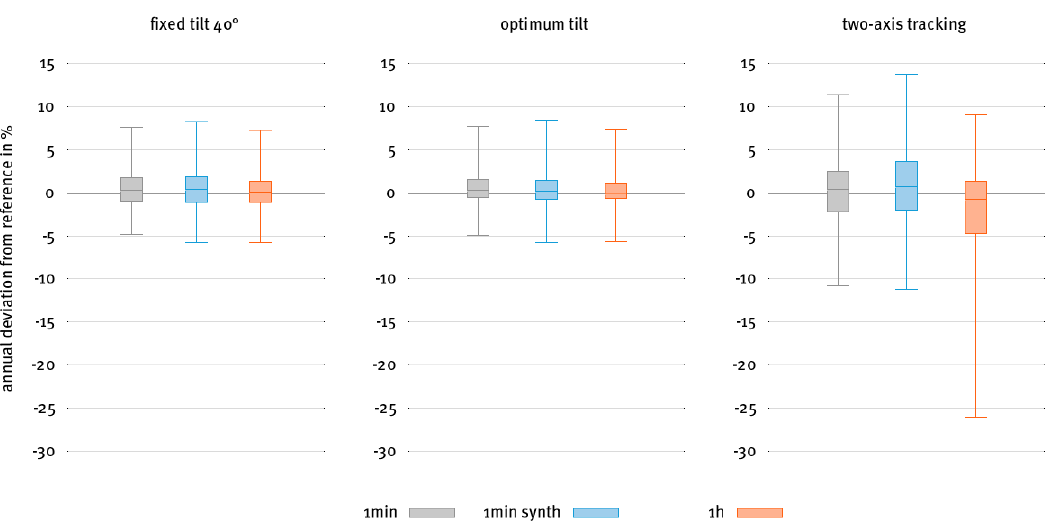
Figure 7. The annual deviation of the modeled PV energy from the reference model chain, grouped by tilt mode and input data type. The reference is calculated from the output of the model chains that contain one-minute measurement data for both global and diffuse irradiation. Each box and whisker contains results from all model chains that can be assigned to the corresponding tilt mode and input data type, i.e., 1200 results per box and whisker (30 locations, eight diffuse fraction models, and five transposition models). Table 4. Inter-annual variability of the results for fixed-tilt systems for the locations of Brasilia, Brazil (BRB), Kwajalein (KWA) and Nauru Island (NAU).